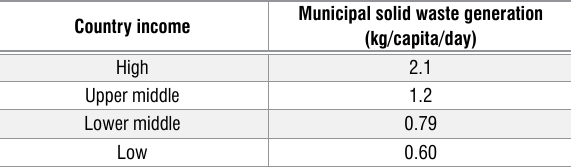
Municipal solid waste generation rates based on country